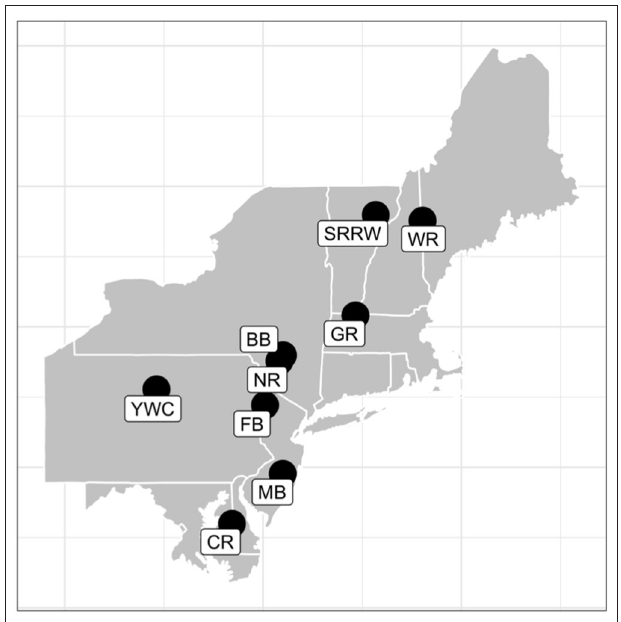
FIGURE 2 | Northeastern headwater catchments in the CAMELS-Chem dataset selected for long-term trend analyses. For full gauge names and gauge numbers see Table 1